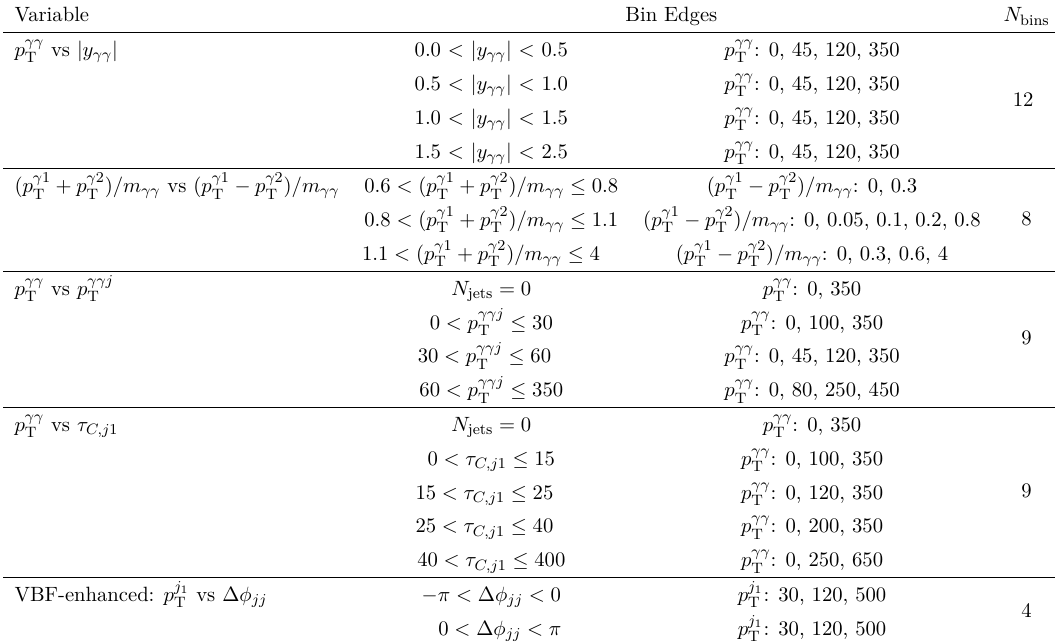
Table 2. Binning for the double-differential cross-section measurements. Transverse momenta and τ variables (defined in the text) are given in